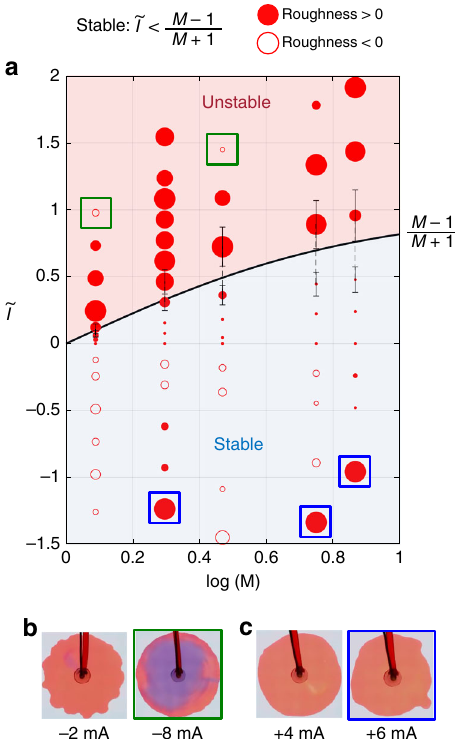
Fig. 5 Dimensionless stability diagram. a Dimensionless stability diagram. The relative roughness at different currents with respect to purely hydrodynamical case (zero current) are plotted as circles, i.e. positive means less stable than hydrodynamical case (plotted as solid circles) and negative means more stable (plotted as open circles). Currents ( I ) are non-dimensionlized using Eq. (3). Note that a positive dimensional current ( I ) yields a negative dimensionless current ð ~ I Þ since ε w ζ w < ε o ζ o in our experiments. For points near the theory line, error bars with ±30% variation in ζ w are plotted for illustrating the uncertainty in water zeta potential. b Anomalous behavior at extreme negative